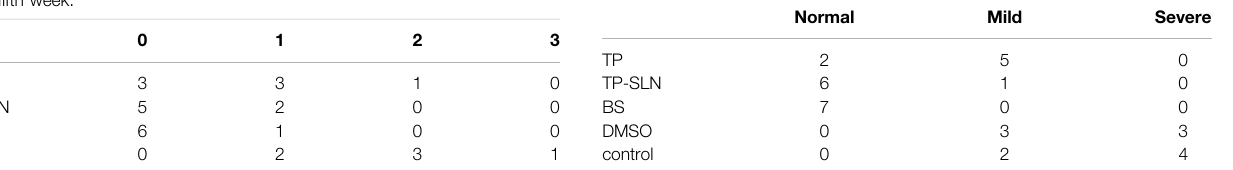
TABLE3| Theultrasonicscoreofthedestructionofthekneejoint ’ sacousticbone in the fi fth week.